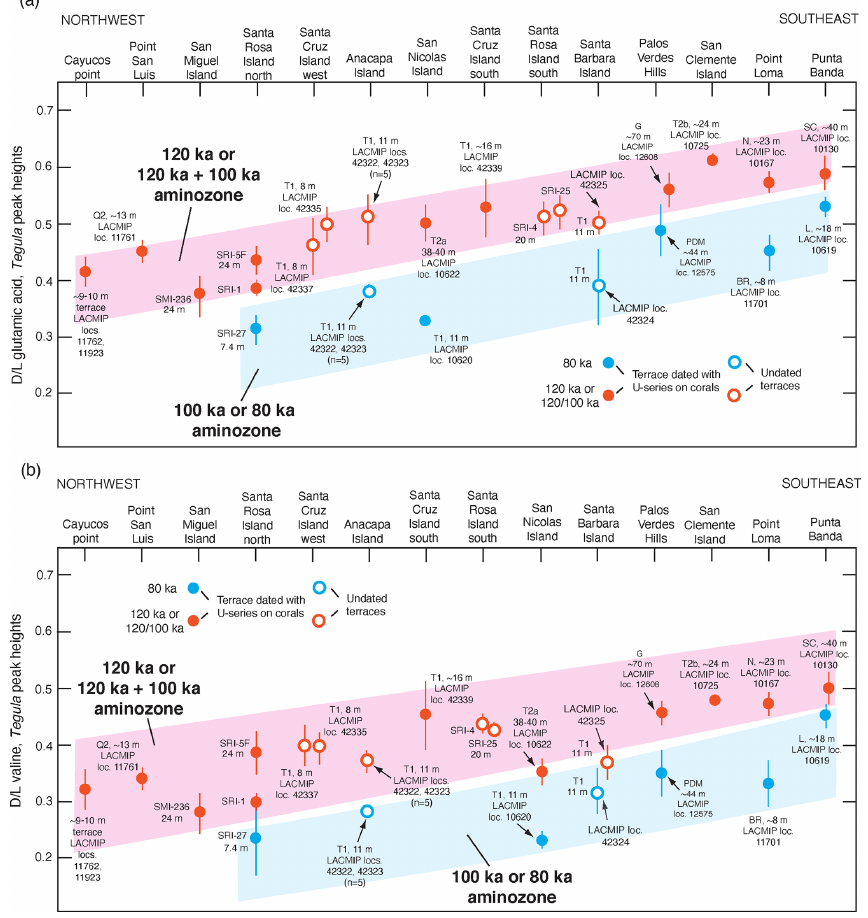
Figure 12. (a) Plot of mean D / L values in glutamic acid (vertical axis) in fossil Tegula from dated (filled circles) and undated (open circles) marine terraces on the California and Baja California coast, shown as a function of latitude (horizontal axis) as a proxy for long-term temperature history, which is cooler in the northwest and warmer in the southeast. Error bars are ± 1 standard deviation, based on D / L values in three to six individual shells from the same deposit. Colored bands (“aminozones”) indicate correlation between fossil localities of the same age, anchored by U-series dating of corals. Terrace name abbreviations: SMI: San Miguel Island, SRI: Santa Rosa Island; SCRZI: Santa Cruz Island; N: Nestor; BR: Bird Rock; PDM: Paseo del Mar; G: Gaffey; SC: Sea Cave; L: Lighthouse; see Muhs et al. (1994, 2002a, 2006, 2014c, 2015) for terrace stratigraphic names and U-series ages. Data from Santa Cruz Island-west, Santa Cruz Island south, Santa Barbara Island, and Anacapa Island are from Muhs and Groves (2018); all other data are from Muhs et al. (2014c). (b) Same as in (a) but for mean D / L values in valine. All data obtained by reverse-phrase liquid chromatography (Kaufman and Manley,